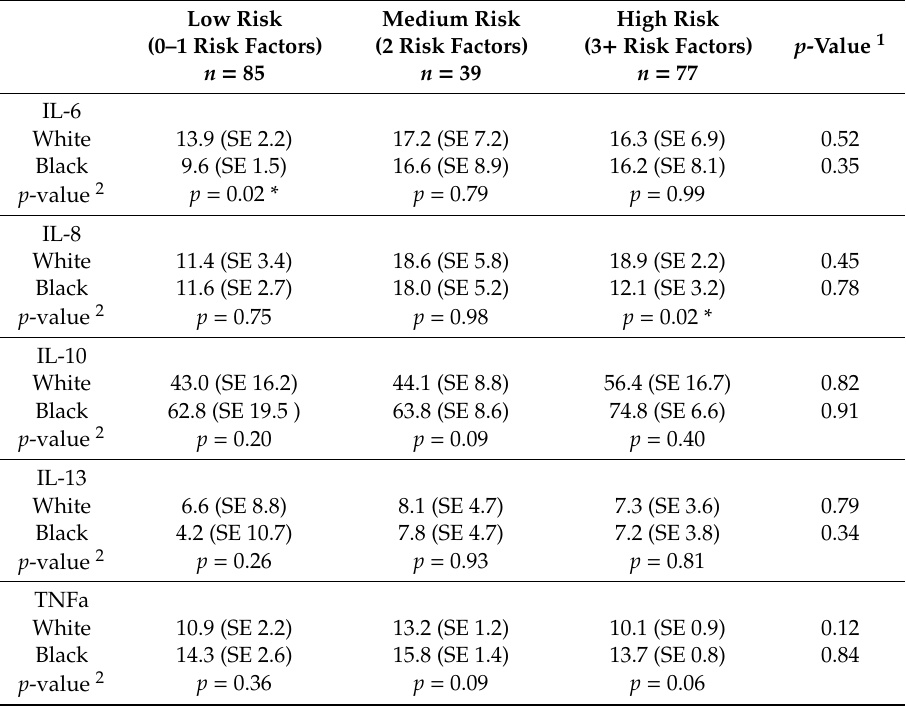
Table 8. Multivariable regression model with adjusted cytokine medians ‡